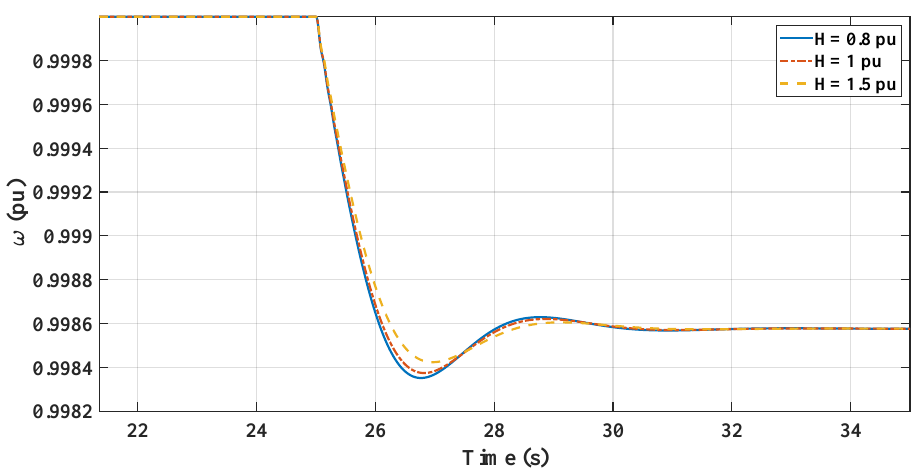
Figure 20. Frequency Response at different generator